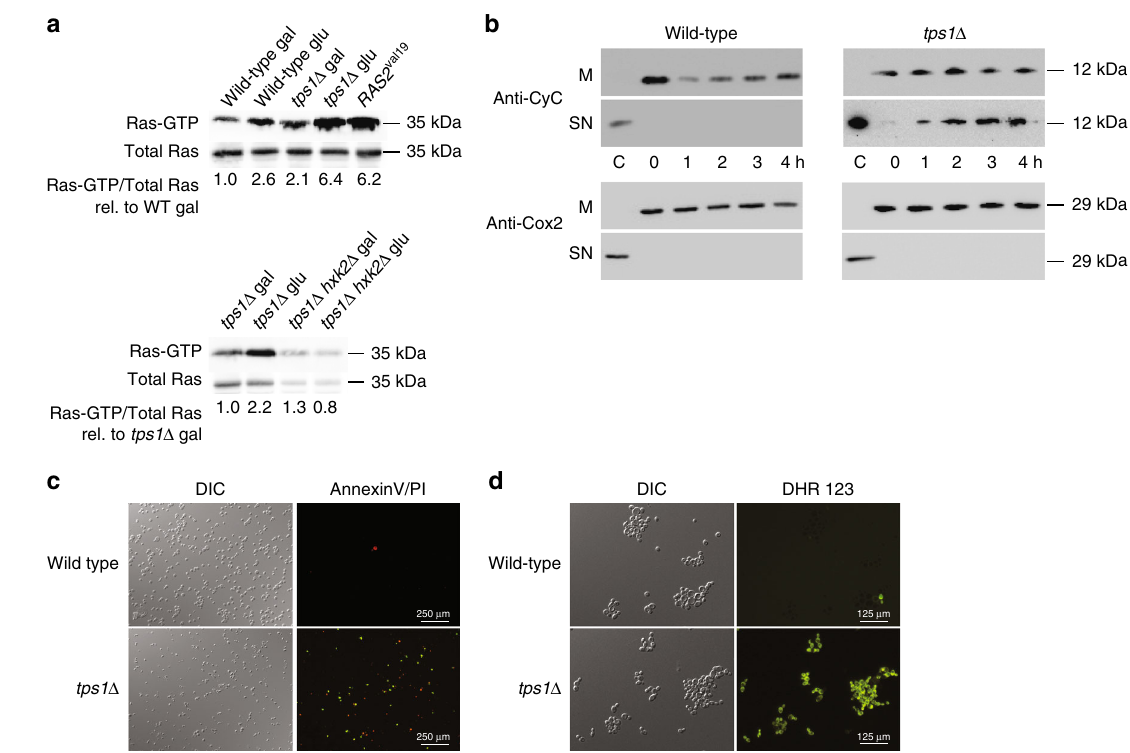
Fig. 2 Glucose triggers activation of Ras and apoptosis in tps1 Δ cells. a Ras-GTP level before and 10 min after addition of glucose (glu) to cells grown on galactose (gal). The strain expressing Ras2 val19 was grown on glucose. Total Ras = Ras-GDP + Ras-GTP. Quanti fi cation of the signals as Ras-GTP level/total Ras level compared to the ratio for wild type or tps1 Δ on galactose set at 1.0. The values were determined through quanti fi cation by densitometry and are expressed as relative arbitrary units. b Speci fi c cytochrome c release from the mitochondria after addition of glucose to wild type and tps1 Δ strain. M, mitochondrial fraction; SN, post-mitochondrial supernatant; Anti-CyC, anti-cytochrome c antibody; Anti-Cox2, cytochrome oxidase 2 antibody; C: control cytochrome c or cytochrome oxidase 2. c Annexin-V-FITC/propidium iodide staining 2h after addition of glucose to cells grown on galactose. Green colored fl uorescence originates from annexin staining, red colored fl uorescence represents propidium iodide binding to DNA of death cells. The scale bar is 250 μ m. d Reactive oxygen species (ROS) accumulation 2 h after addition of glucose to cells grown on galactose. ROS was stained with the dye dihydrorhodamine 123. DIC, differential interference contrast image. The scale bar is 125 μ